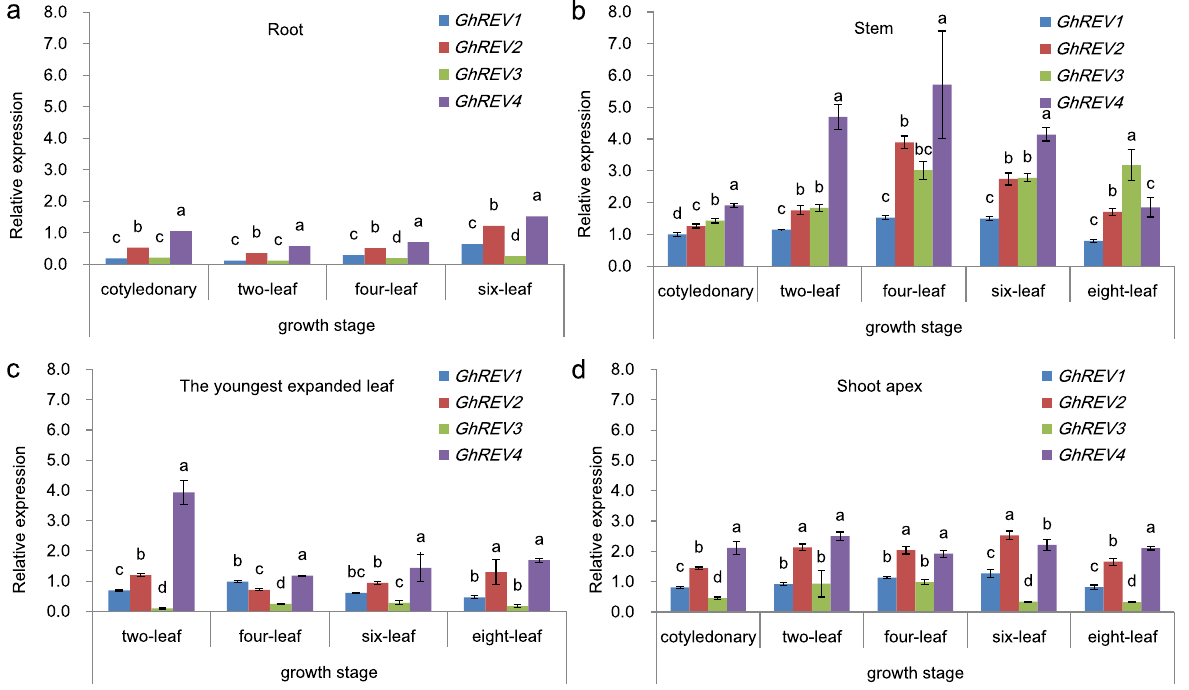
Fig. 2 The expression levels of GhREVs family members in root ( a ), stem ( b ), the youngest expanded leaf ( c ) and shoot apex ( d ) at cotyledonary, the 2 nd , 4 th , 6 th , and 8 th leaf stages. The expression of GhREV1 in stem was regarded as ‘ 1 ’ . GhActin9 was used as the internal control. There were no data of roots at the 8 th leaf stage due to the failure of RNA extraction